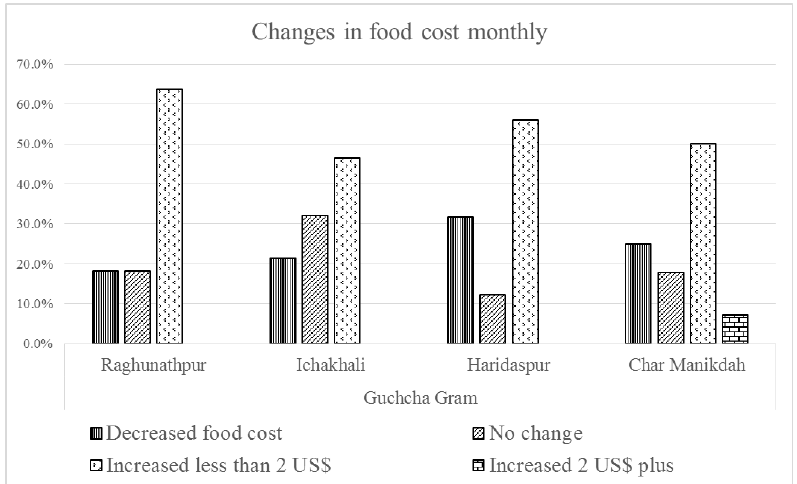
Figure 3. Changes in monthly food cost; Source: Field survey 2014.